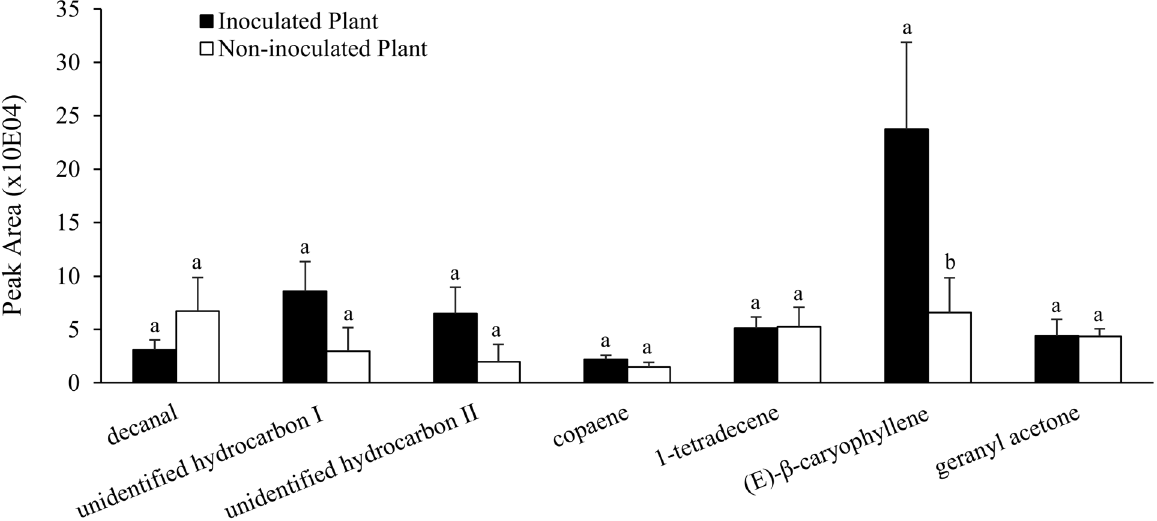
Figure 3. Root volatile profile induced by Azospirillumbrasilense colonization. Emissions of volatile compounds from inoculated and non- inoculated corn roots. Bars represent the mean 6 SE. Different letters indicate a significant difference between treatments according to One-Way ANOVA followed by Tukey’s HSD test (n=4, P , 0.05).